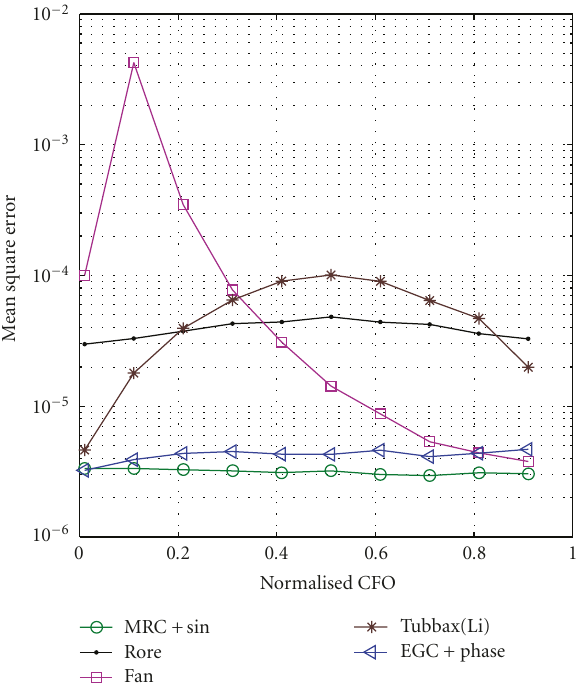
= 10 dB and 22 dB in the presence of 1dB gain mismatch and 1 ◦ phase